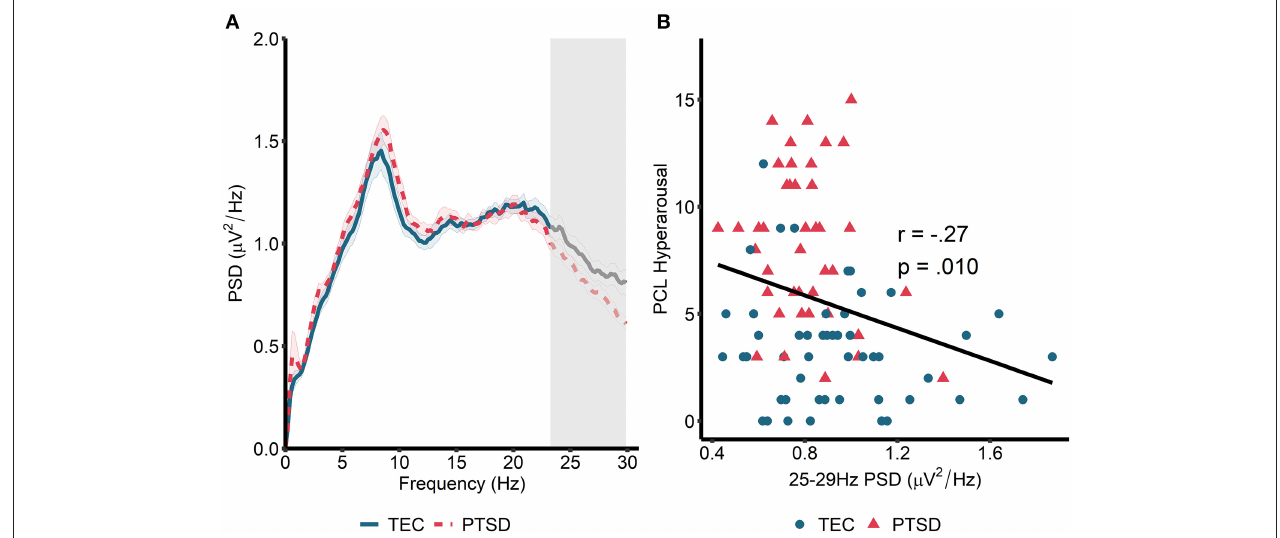
FIGURE 2 | Power spectral density during REM sleep. (A) 0–30Hz power spectrum during REM sleep. Note that PSD at each frequency is relative to the average PSD in the 0–30Hz range. Gray box marks frequencies showing significant correlations with hyperarousal symptomatology across all participants following cluster correction. Shaded area around lines denotes the standard error. Note that no overall group differences were observed. (B) Scatterplot visualizing the relationships between cluster-averaged spectral power and hyperarousal symptomatology.